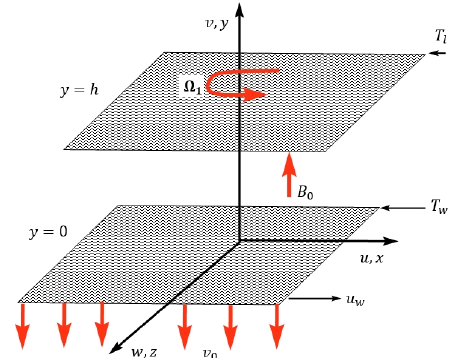
Figure 1. Flow geometry of the model.